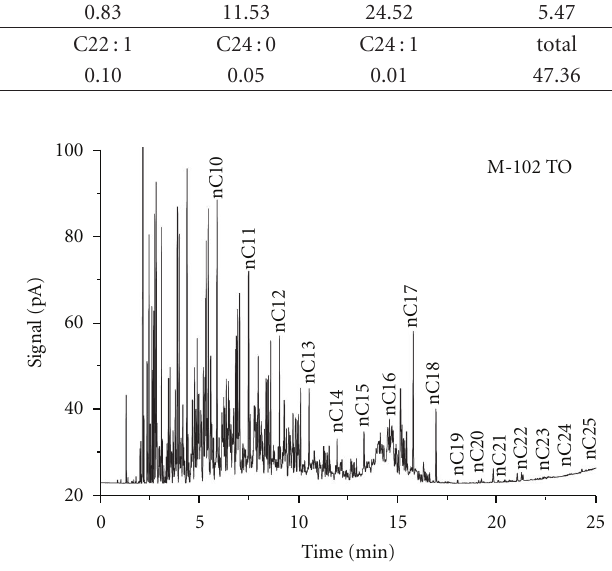
Figure 1: GC chromatogram of liquid product—hydrotreating CTO in isooctane on catalyst